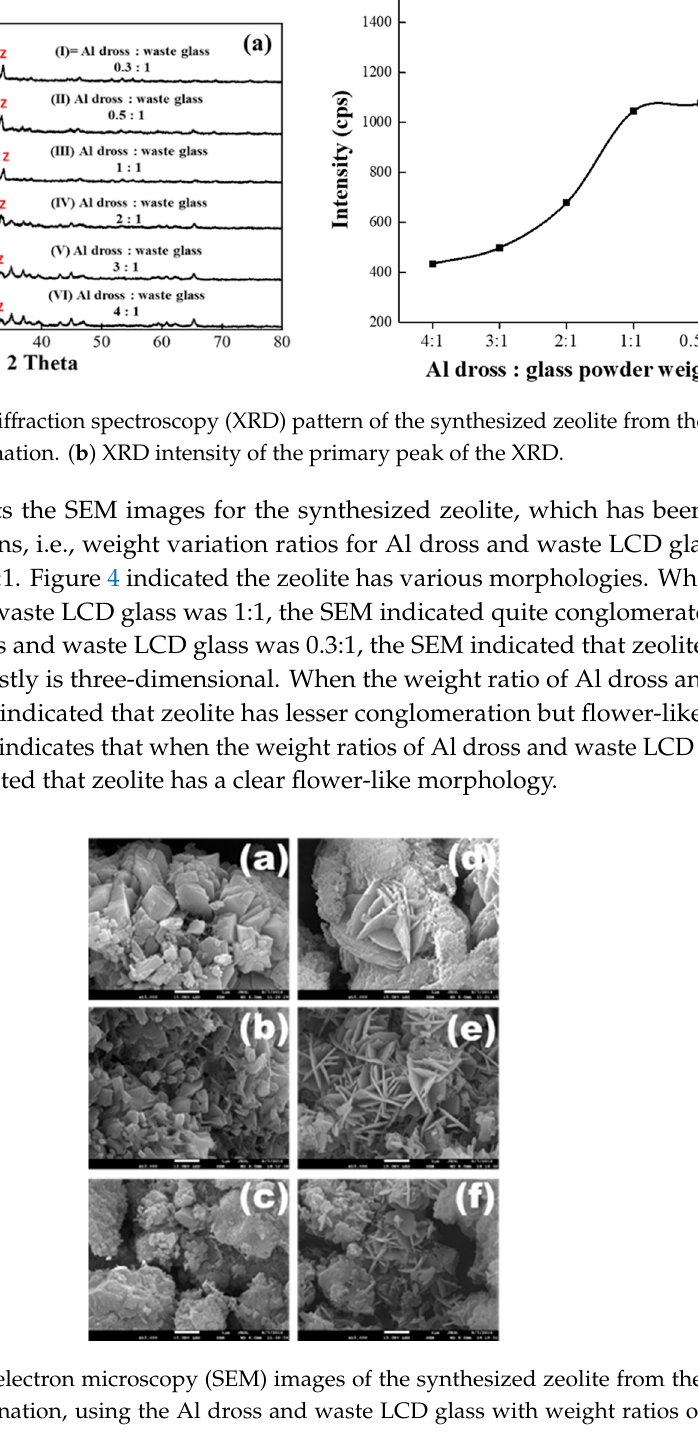
Table 2. Brunauer–Emmett–Teller (BET) analysis for zeolite synthesized using various conditions. Al Dross: Waste LCD (wt/wt)